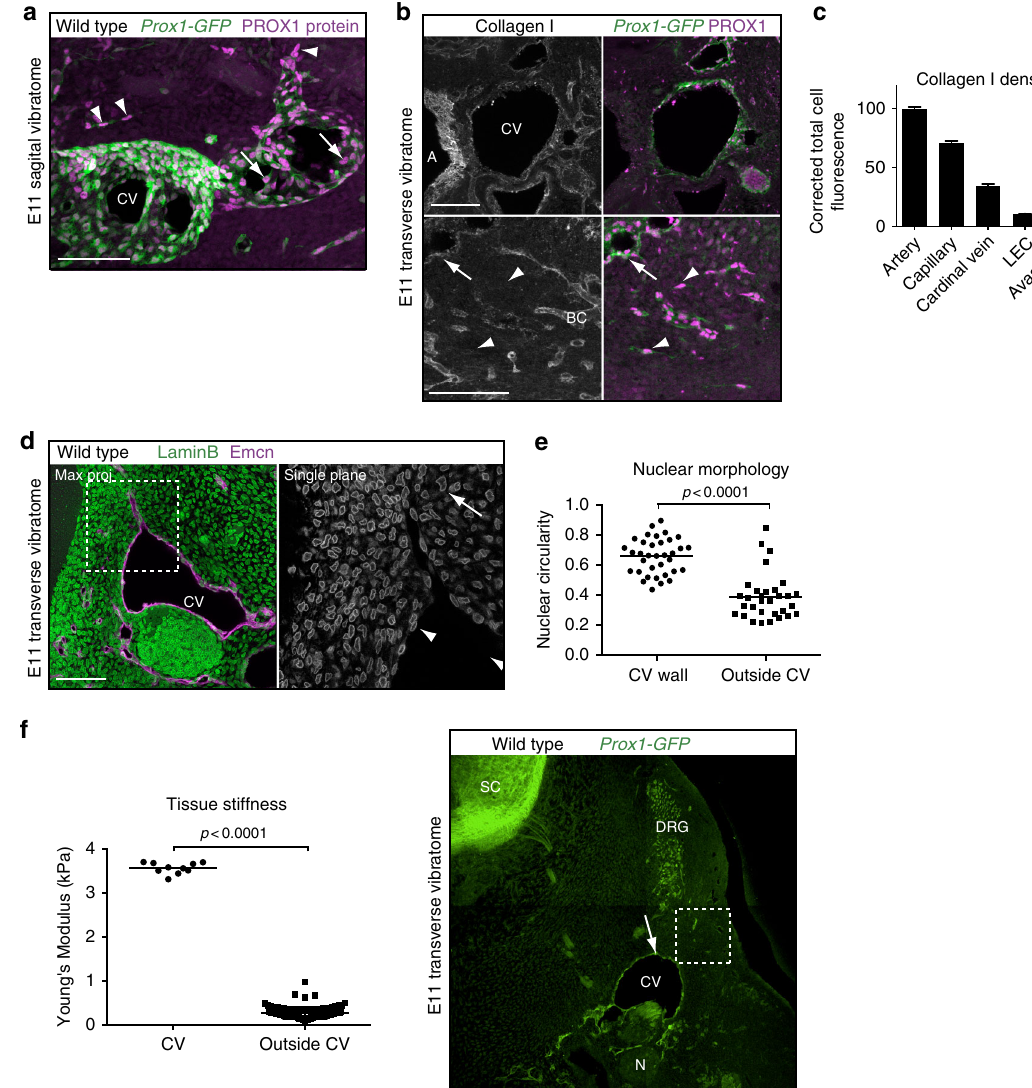
Fig. 1 Venous LEC progenitors experience lower matrix stiffness upon migration out of the cardinal vein. a , b Immuno fl uorescence of sagittal ( a ) and transverse ( b ) vibratome sections of E11 Prox1-GFP embryos using antibodies against PROX1 (magenta), GFP (green, Prox1 reporter) and Collagen I (single channel images in B only). In a , note the round nuclear shape of PROX1 + LECs in the cardinal vein (CV) (arrows) compared to elongated nuclei of the migrating PROX1 + LECs (arrowheads) in the surrounding tissue. In b , aorta (A) and blood capillaries (BC) show higher Collagen I levels compared to CV (arrow) and migrating LECs (arrowheads). c Quanti fi cation of Collagen I density in the respective vessel types and avascular tissue in E11 embryos. Data represent mean integrated density values of corrected total cell fl uorescence ± s.e.m. (unpaired Student ’ s t -test) quanti fi ed from n = 10 images taken from two embryos. d Immuno fl uorescence of transverse vibratome sections of E11 wild type embryos using antibodies against Emcn (magenta; marker of venous EC) and LaminB (green, marker of nuclear envelope). Single plane image for LaminB staining is shown as a close-up (grey). Nuclear morphology is distorted in cells outside the CV (arrow), as opposed to a round morphology in cells of the CV vessel wall (arrowhead). e Quanti fi cation of nuclear circularity of Emcn + venous ECs (CV wall) and Emcn − cells of the surrounding tissue (outside CV). Horizontal lines represent mean ( n = 30 (CV wall) and n = 34 (outside CV) from two embryos). p value, unpaired Student ’ s t -test. f Ex vivo AFM measurements (graph on the left) in transverse vibratome sections (image on the right) of E11 Prox1-GFP embryos. Young ’ s Modulus (kPa) is a measure for the actual tissue stiffness. Horizontal lines represent mean ( n = 10 measurements from one embryo (CV) and n = 114 measurements from three embryos (outside CV)). p value, unpaired Student ’ s t -test. Measurements were done on the dorsal side of the CV (arrow) and the area of LEC migration (boxed area, outside CV). Prox1-GFP + spinal cord (SC), dorsal root ganglion (DRG) and nerve (N) were used for orientation. Scale bars: 100 µ resource TFactS 28 (Supplementary Data 1). These included the mechanosensitive GATA2 transcription factor that was pre- viously shown to regulate the LEC response to shear stress 18,19 , and respond to ECM-derived mechanical signals in blood ECs (BECs) by changing its nuclear/cytoplasmic localization 17 . Fur- kPa) in comparison to stiff (25 kPa) matrices validated the array thermore, GATA2 has been identi fi ed as a causative gene for data and showed a 2-fold increase in GATA2 mRNA levels.